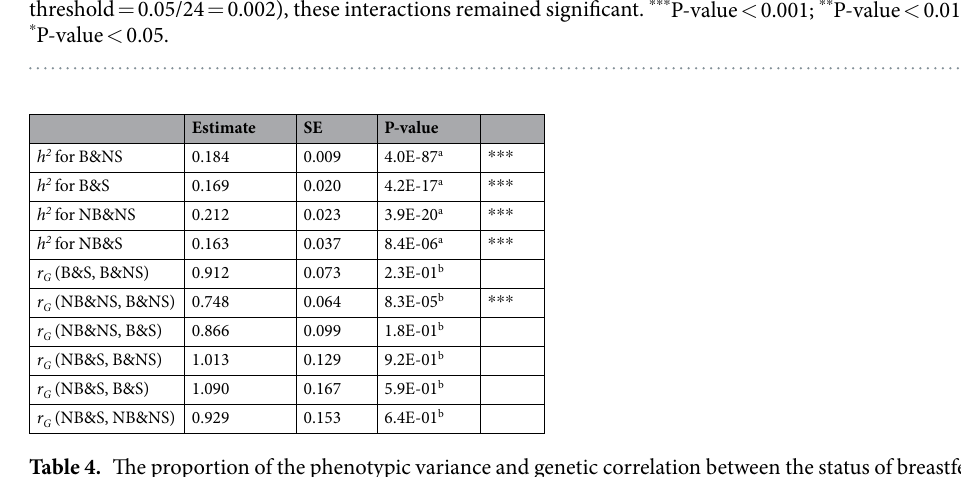
Table 4. The proportion of the phenotypic variance and genetic correlation between the status of breastfeeding and maternal smoking around birth for educational attainment. a Testing if the estimate is different from 0. b Testing if the estimate is different from 1; The genetic correlation ( r G ) between NB&NS and B&NS is significantly different from 1 as an evidence of G × E. Even after a multiple testing correction (p-value threshold = 0.05/24 = 0.002), the interaction remained significant. *** P-value < 0.001; ** P-value < 0.01; * P-value <